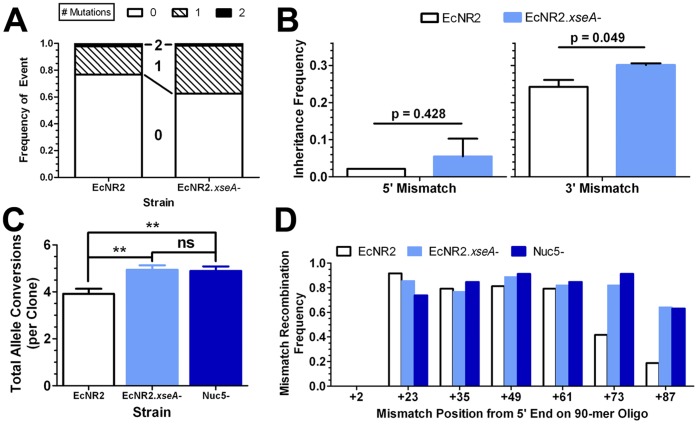
Removal of ExoVII Preserves Mutation Inheritance. A)A non-phosphorothioated lacZ::kanR dsDNA cassette with two 2 bp sets of mismatch mutations (placed 7&8 bp from each end of the cassette) was recombined into EcNR2 and EcNR2.xseA
− cells. Resulting kanR recombinants were then genotyped in order to determine whether they inherited these distally-located mutations. The distribution of mutations in EcNR2 (two independent experiments, n = 180) and EcNR2.xseA
− (two independent experiments, n = 177) was plotted as the frequency of clones inheriting 0 (empty black bars), 1 (hatched black bars), or 2 (filled black bars) sets of mutations. B) When the inheritance of each 2 bp mutation is considered individually, both show increased preservation in EcNR2.xseA
−, although this is only statistically significant for the 2 bp mutation on the 3′ end of the cassette (as defined with respect to the lagging-targeting strand). Data are presented as the mean with the standard deviation from the mean. C & D) A 90mer lagging strand-targeting oligonucleotide was designed to introduce 7 stop codons (placed at the +2, +23, +35, +49, +61, +73, +87 base pair positions with respect to the 5′ end) into the lacZ gene. This oligo was transformed into EcNR2, EcNR2.xseA
−, and nuc5− cells. LacZ− cells were identified and their lacZ genes sequenced in order to determine which mutations were conferred in a given clone. The average total number of stop codons introduced into a given clone is shown in C). Both EcNR2.xseA
− (**p = 0.0004, n = 54) and nuc5− (**p = 0.001, n = 46) exhibit similar, statistically significant increases in total mutation inheritance compared to EcNR2 controls (n = 45). A breakdown of each strain’s inheritance of each mutation is given in D). Both EcNR2.xseA
− and nuc5− show similarly increased inheritance of 3′-located mutations, but no increased inheritance of 5′-located mutations. No clones inherited the mutation encoded at position +2. Data in C) are presented as the mean with the standard error of the mean.